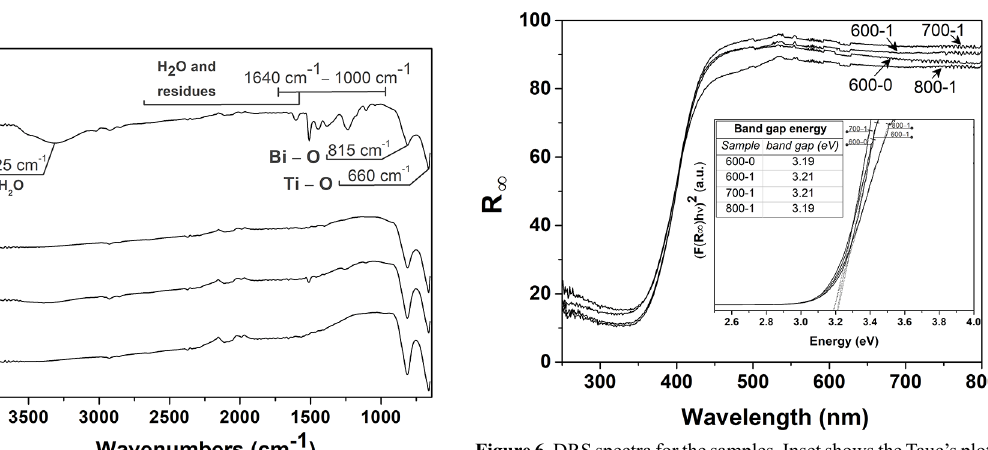
Figure 6. DRS spectra for the samples. Inset shows the Tauc’s plots and the samples’ band